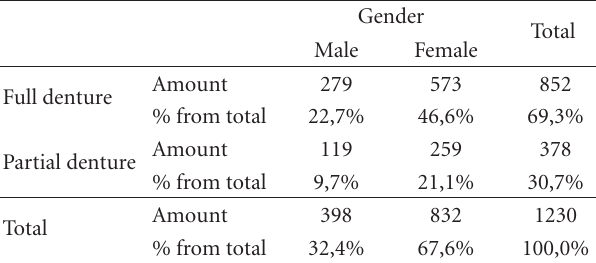
Figure 1: Sampling site of the material for mycological examina- tions. The dashed line on the photograph indicates the “sampling site” localized between the anatomic second and third palatal folds.